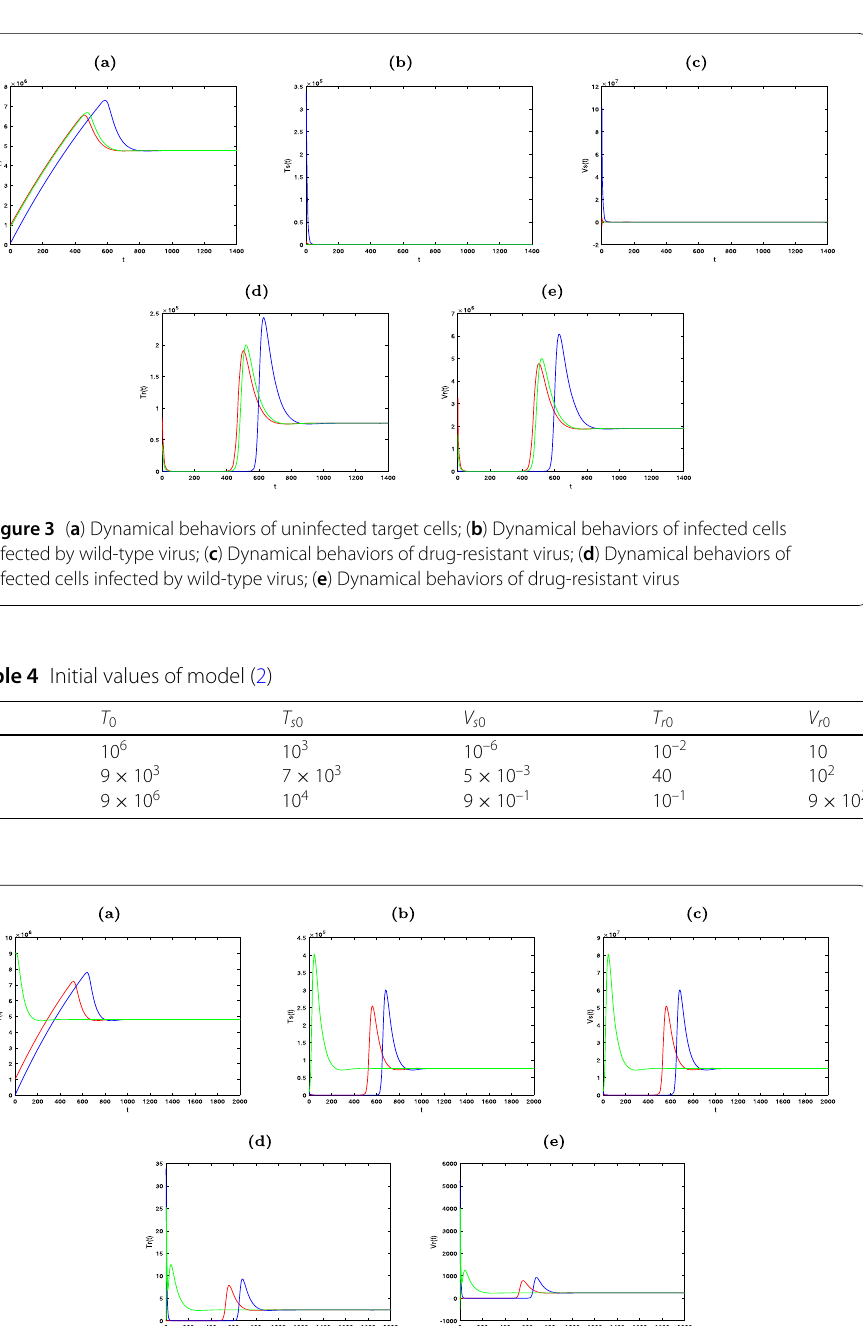
Figure 4 ( a ) Dynamical behaviors of uninfected target cells; ( b ) Dynamical behaviors of infected cells infected by wild-type virus; ( c ) Dynamical behaviors of drug-resistant virus; ( d ) Dynamical behaviors of infected cells infected by wild-type virus; ( e ) Dynamical behaviors of drug-resistant virus